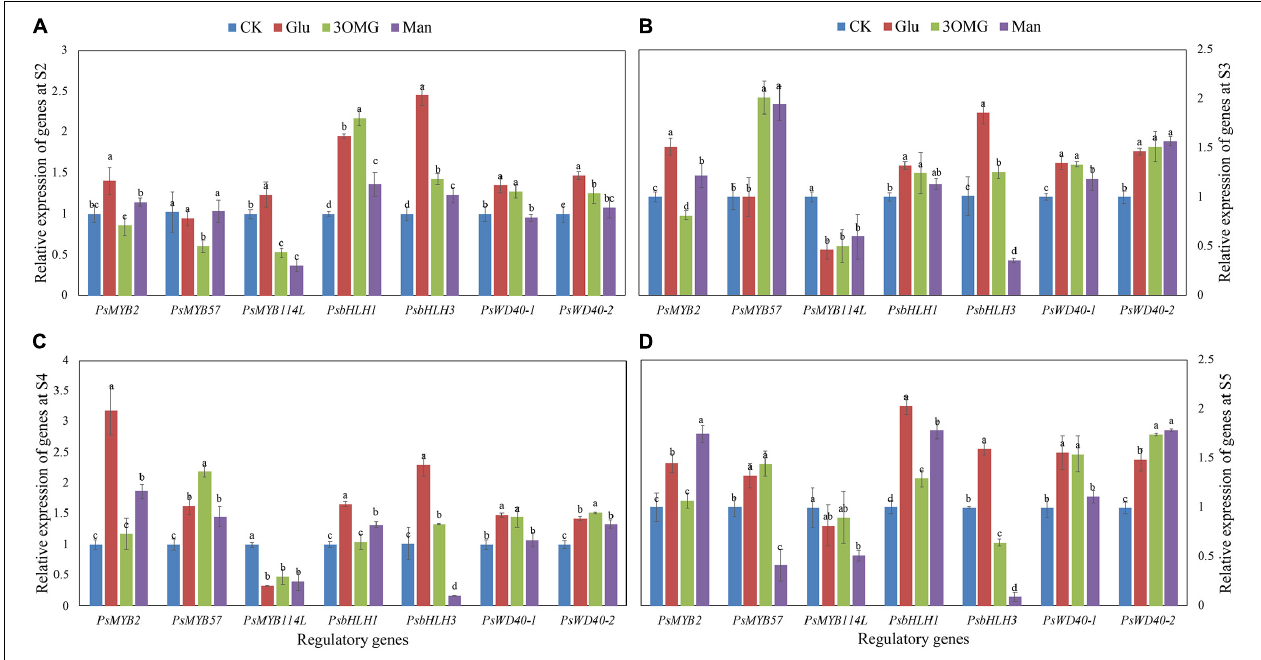
FIGURE 5 | Relative expression levels of seven anthocyanin biosynthetic regulatory genes in petals of P. suffruticosa ‘Tai Yang’ cut flowers under four treatments. (A) S2, pre-opening stage; (B) S3, initial opening stage; (C) S4, half opening stage; (D) S5, full opening stage. There were four treatments including CK, Glu, 3OMG, and Man, respectively. CK was the control group that cut flowers treated with distilled water. Glu, 3OMG, and Man were the cut flowers treated with glucose, 3-O-methylglucose, and mannose at 333 mM, respectively. Each value was expressed as the mean ± standard errors (SE) of triplicate replications. Different small letters indicated significant differences among treatments at the same developmental stage according to Duncan’s multiple range test at p < 0.05.